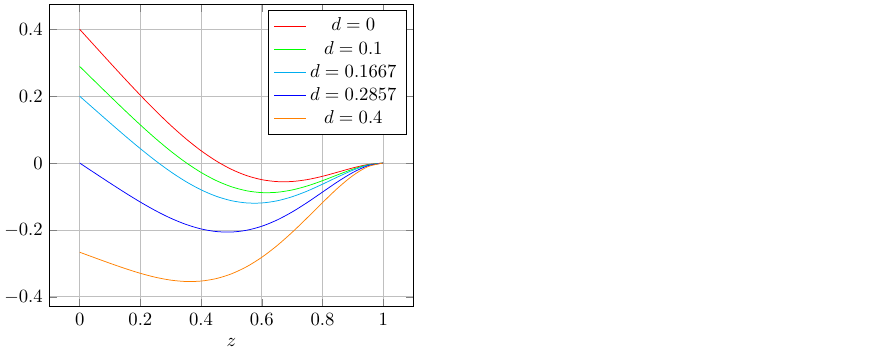
Figure 4. Graph of ˜ g with several values of d . Observe that, if z = 0, ˜ g = 0 when d = d 2 ( 0.2857 ) . Parameters: n = 5, r = 3, and σ = 1.